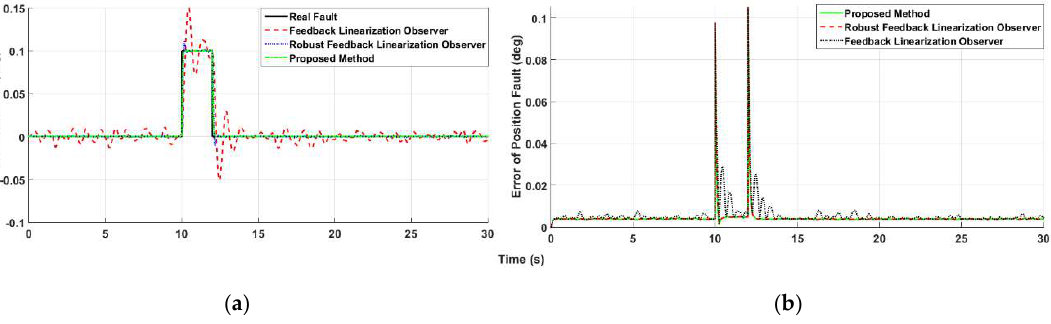
Figure 10. Results for the fuzzy ARX-Laguerre feedback linearization method, fuzzy ARX-Laguerre robust feedback linearization method, and fuzzy ARX-Laguerre T–S fuzzy robust feedback linearization method for the surgical robot for the sinus. ( a ) Position fault estimation accuracy. ( b ) Fault estimation error of position estimation.